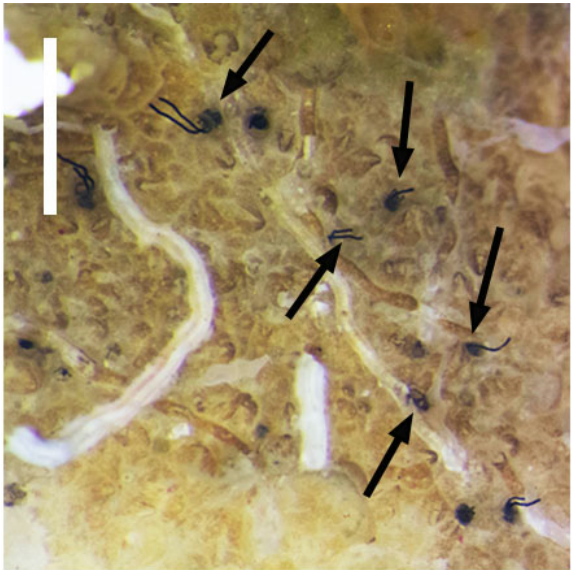
Figure 2. Colony deprived of tubes. The paired arms of several individuals are visible (arrows). Scale bar 1 mm.